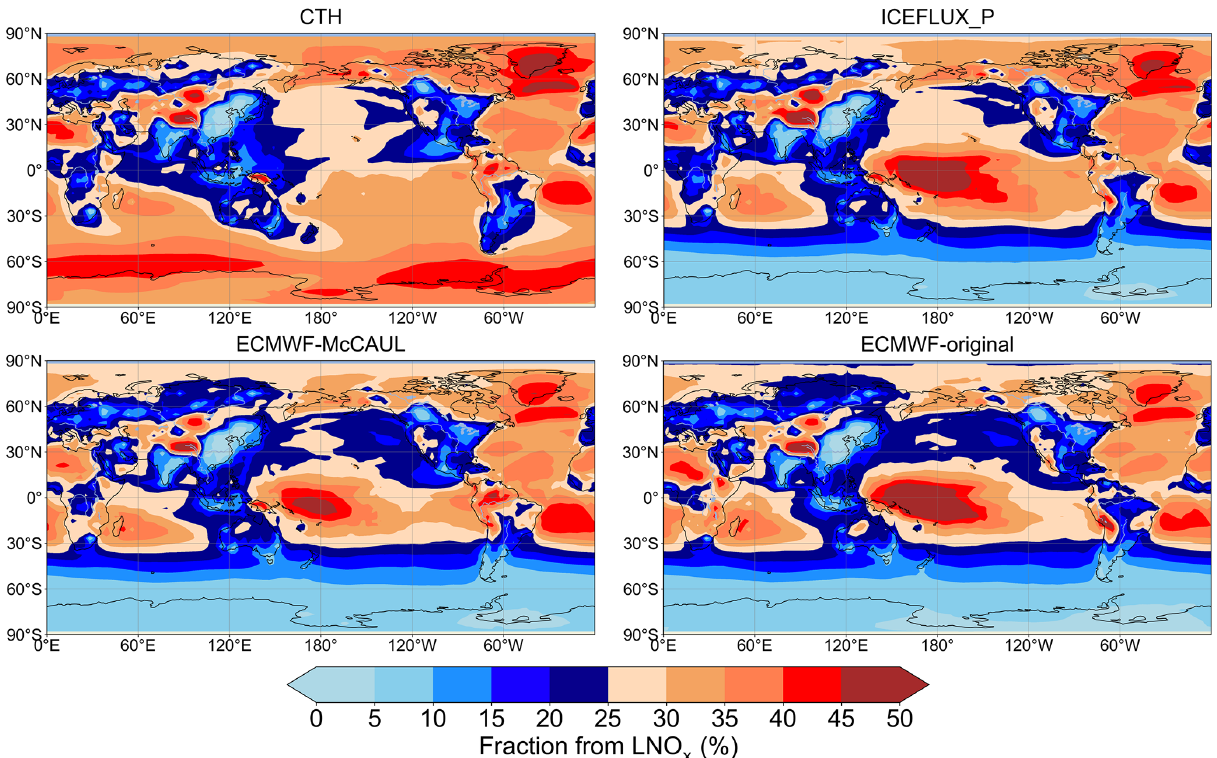
Figure 8. Sensitivity of simulated tropospheric NO 2 columns to LNO x emissions using different lightning schemes in 2019. NO 2 column because of LNO x emissions was determined as the difference between the simulation with LNO x emissions and a simulation that excludes LNO x emissions.